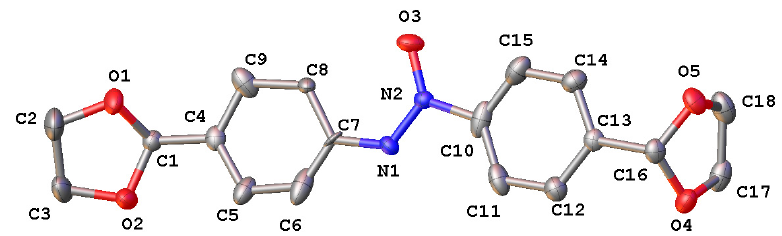
Figure 2. Crystal structure of compound 4 with labeling schemes and 50% thermal ellipsoids. Deprotection of 1,3-dioxolane 4 was carried out with concentrated hydrochloric acid on a solution of 4 in tetrahydrofuran (THF) at room temperature (Scheme 3) [34]. The yield of bis -aldehyde 5 was 80% after recrystallization. Its structure was confirmed by 1 H and 13 C NMR and mass spectrometry.